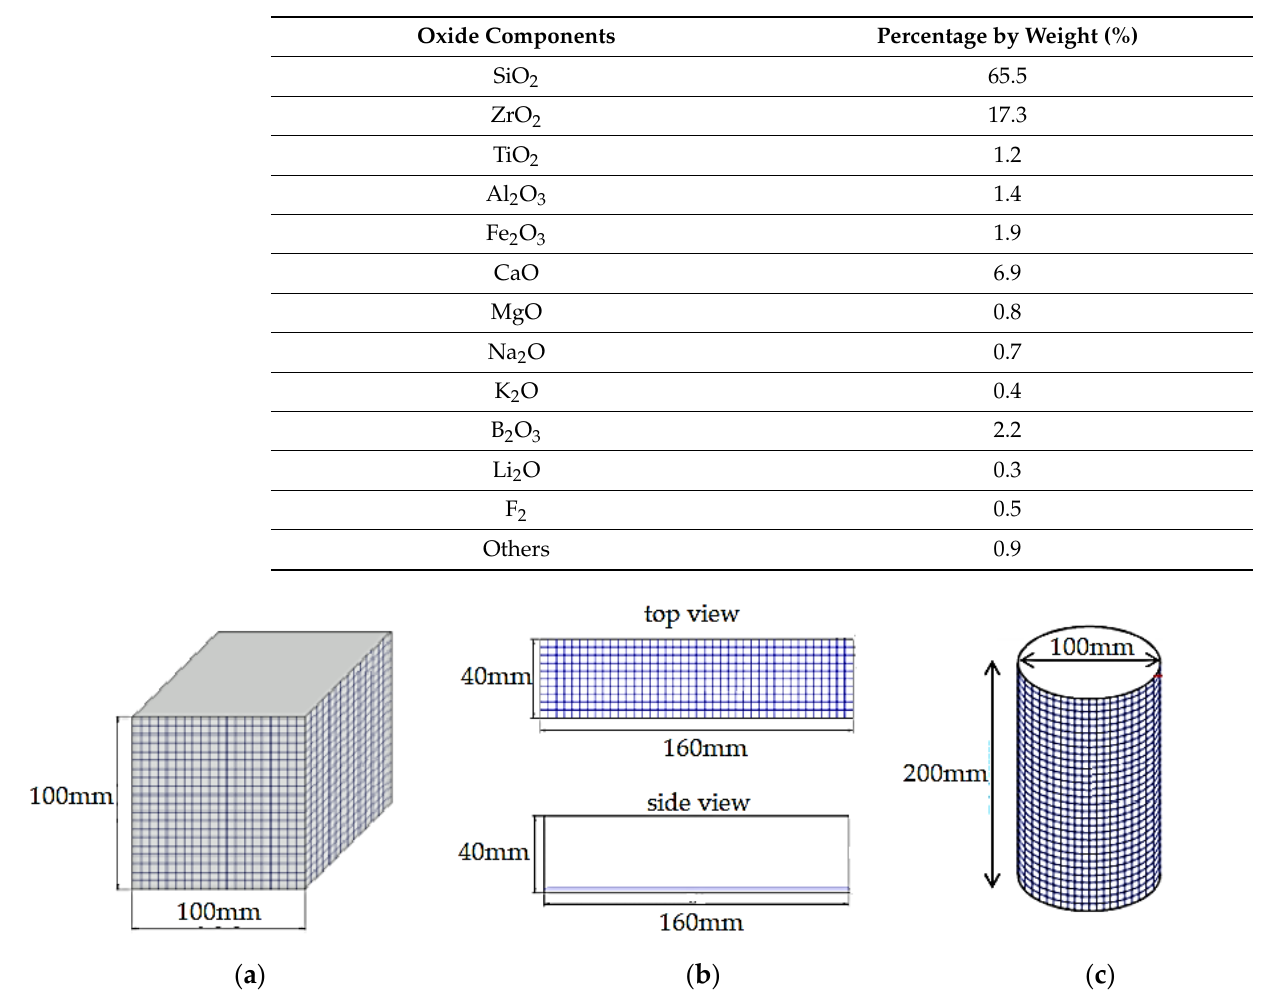
Figure 1. Fiberglass mesh (FM). Table 1. Chemical composition of FM.